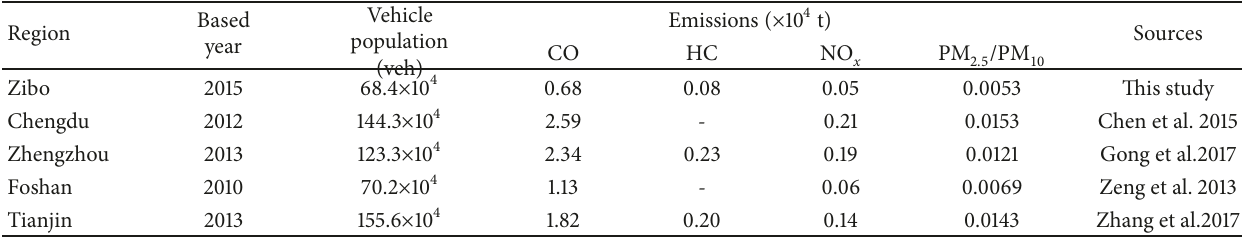
Table 15: Comparison of emission inventory between Zibo and other